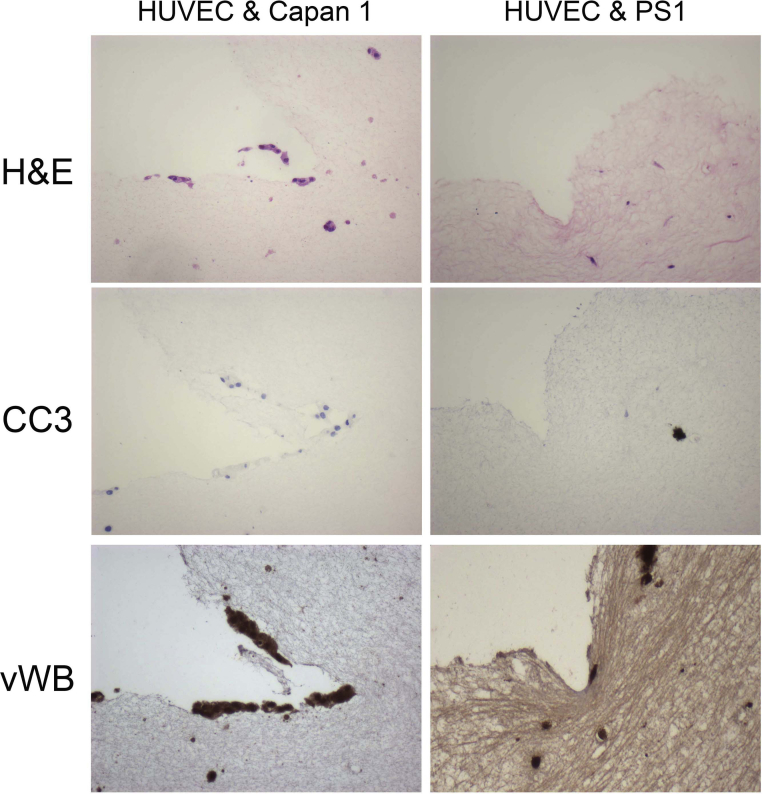
Supplementary Figure 4Organotypic cultures' consecutive sections stained for cleaved caspase 3 and von Willebrand factor. HUVEC-Capan1 and HUVEC-PSC double organotypic cultures were used. Consecutive sections were stained for stained for cleaved caspase 3 and von Willebrand factor.